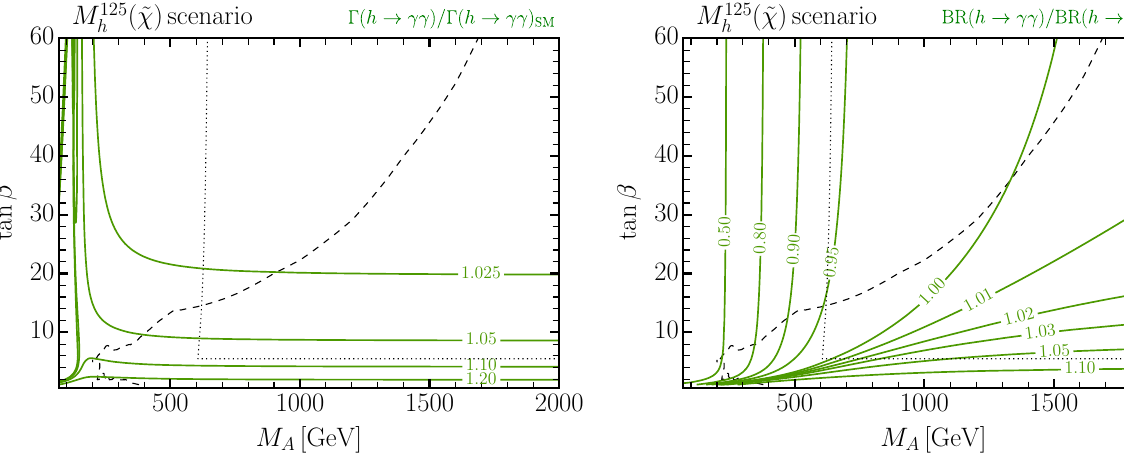
Fig. 6 Left: Decay width of the lighter CP -even scalar into photons each plot, the boundaries of the blue and the hatched exclusion regions ( ˜ χ) scenario, normalized to as a function of M A and tan β in the M 125 of Fig.5 are also shown as a dashed and a dotted black line, h the corresponding width of a SM Higgs boson of the same mass. Right: same as the left plot for the branching ratio of the decay h → γγ . In